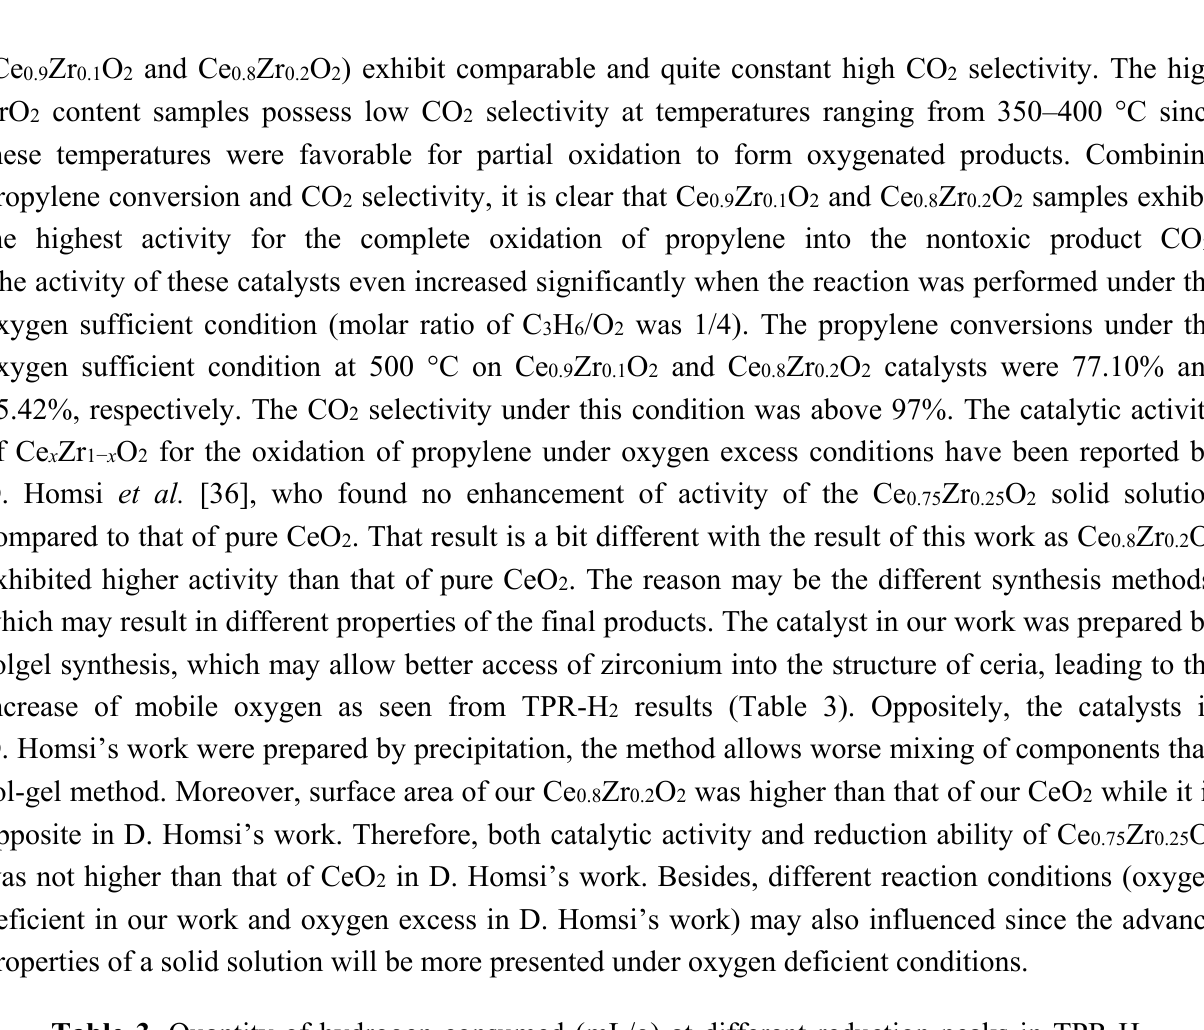
Table 3. Quantity of hydrogen consumed (mL/g) at different reduction peaks in TPR-H